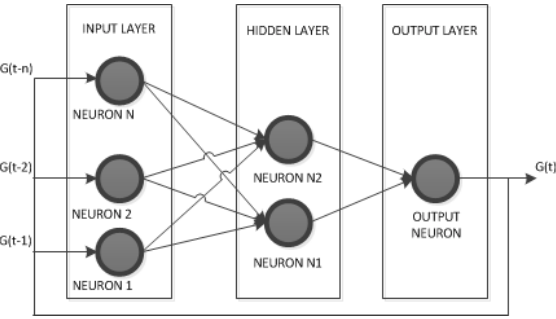
Figure 5. Diagram of a non – linear autoregressive network (NAR).